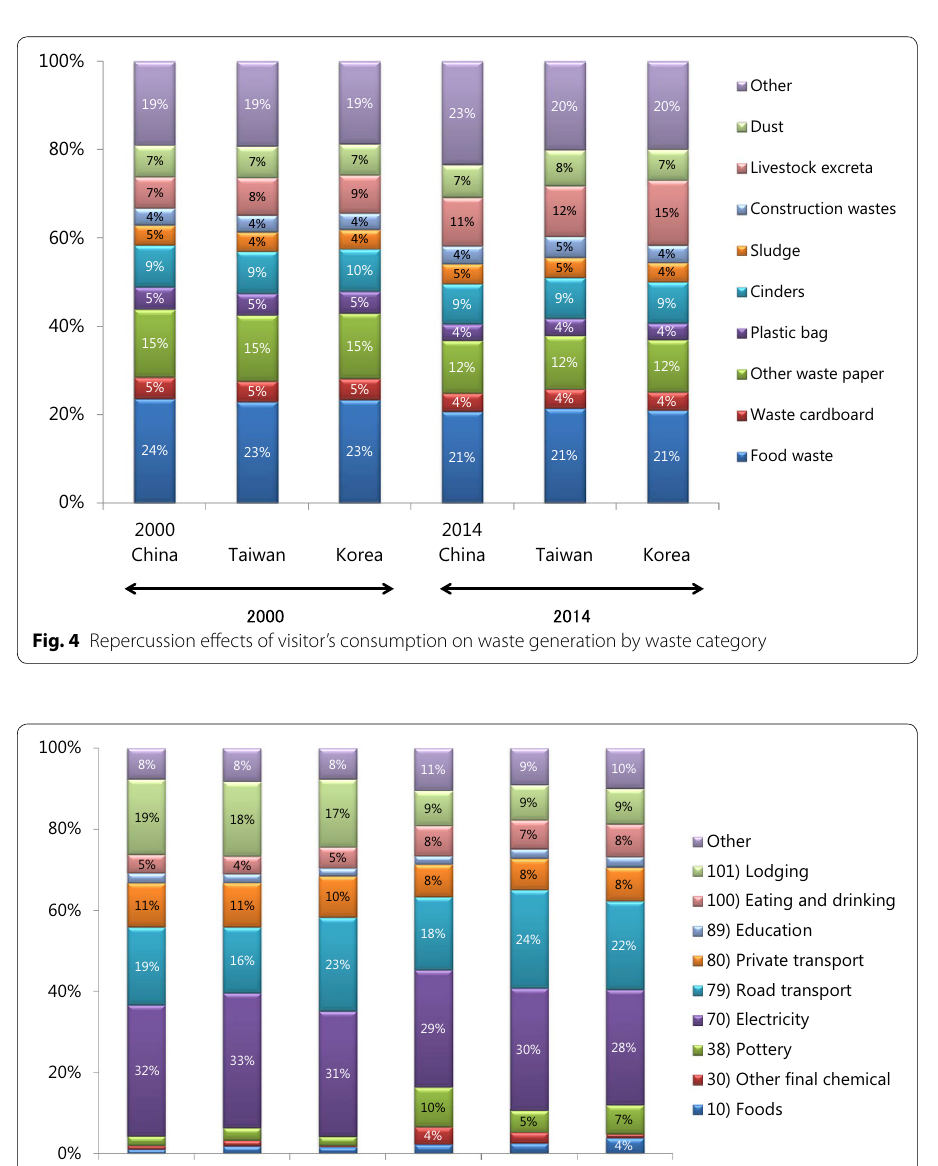
Fig. 5 Repercussion effects of visitor’s consumption on GHG emission by